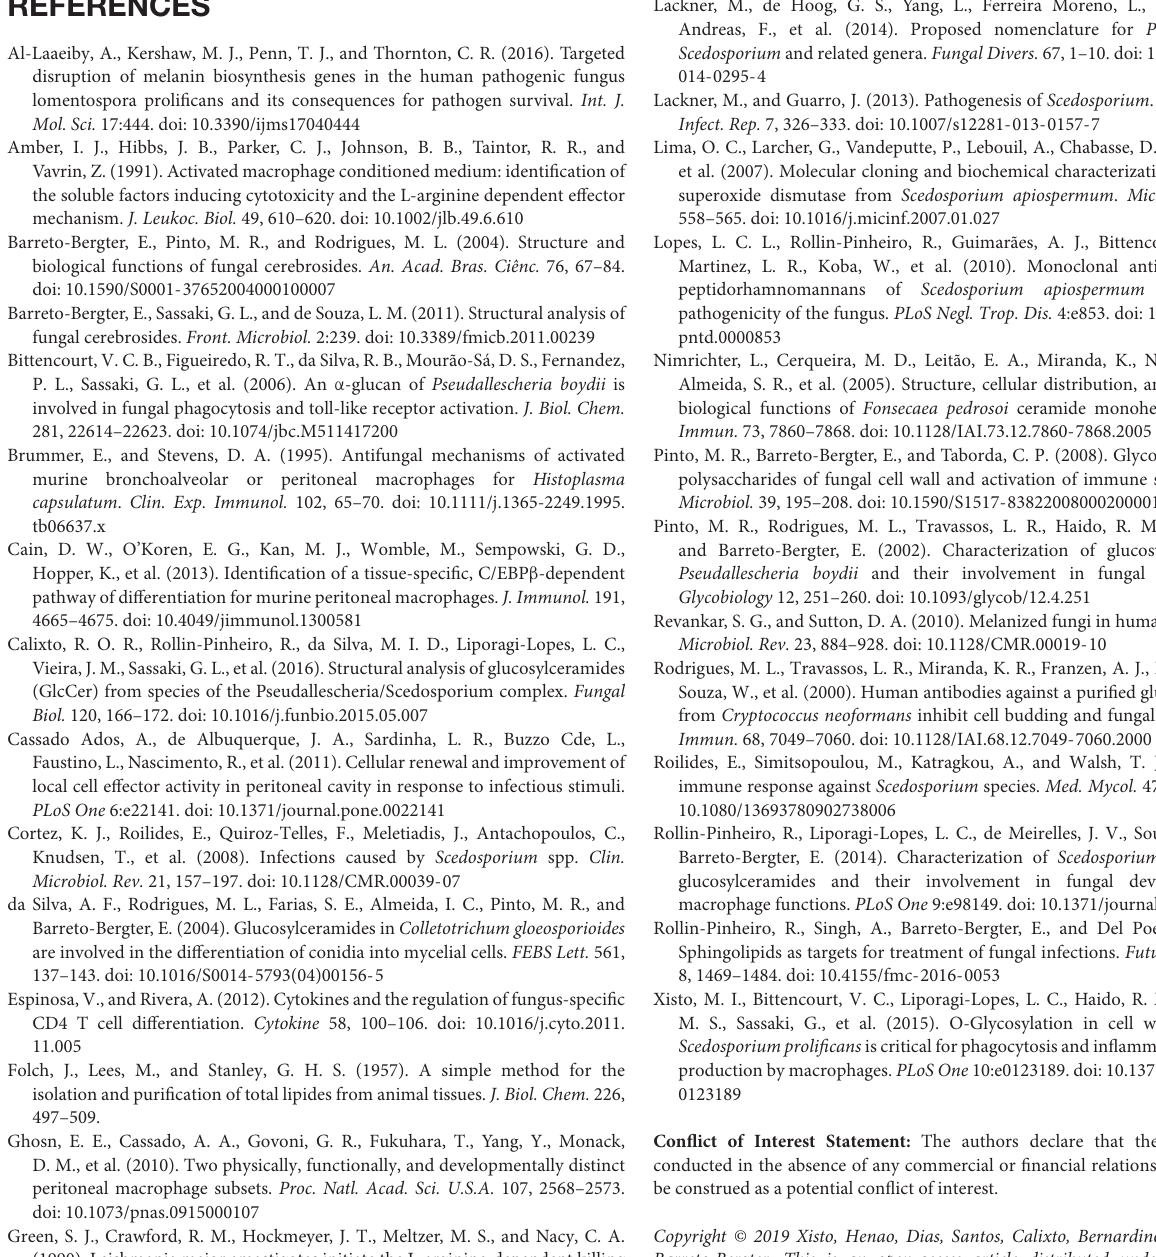
FIGURE S1 | Flow Cytometry analysis of the cells recruited to the peritoneum cavity. Mice were injected intraperitoneally with 0.5% DMSO in PBS (vehicle) or 200 µ g of GlcCer from mycelium. After 24 h, the mice were euthanized and the cells recruited to peritoneal cavity was evaluated by flow cytometry. The panel with